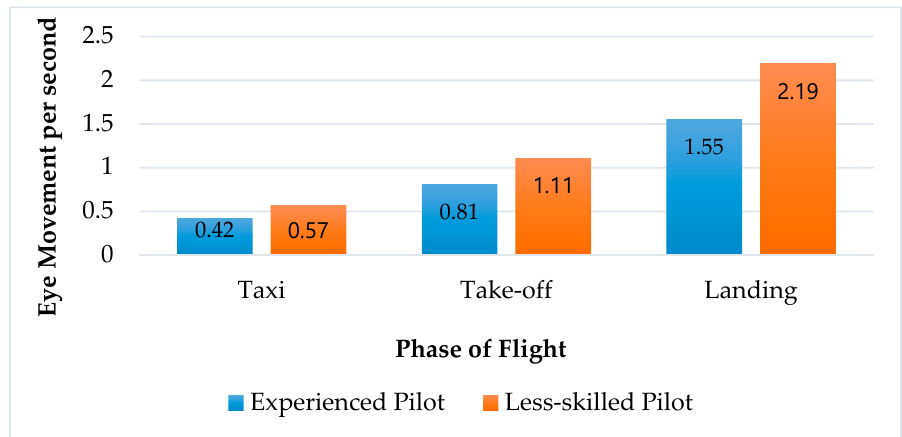
Figure 12. Comparison of eye movement between experienced and less-skilled pilots.